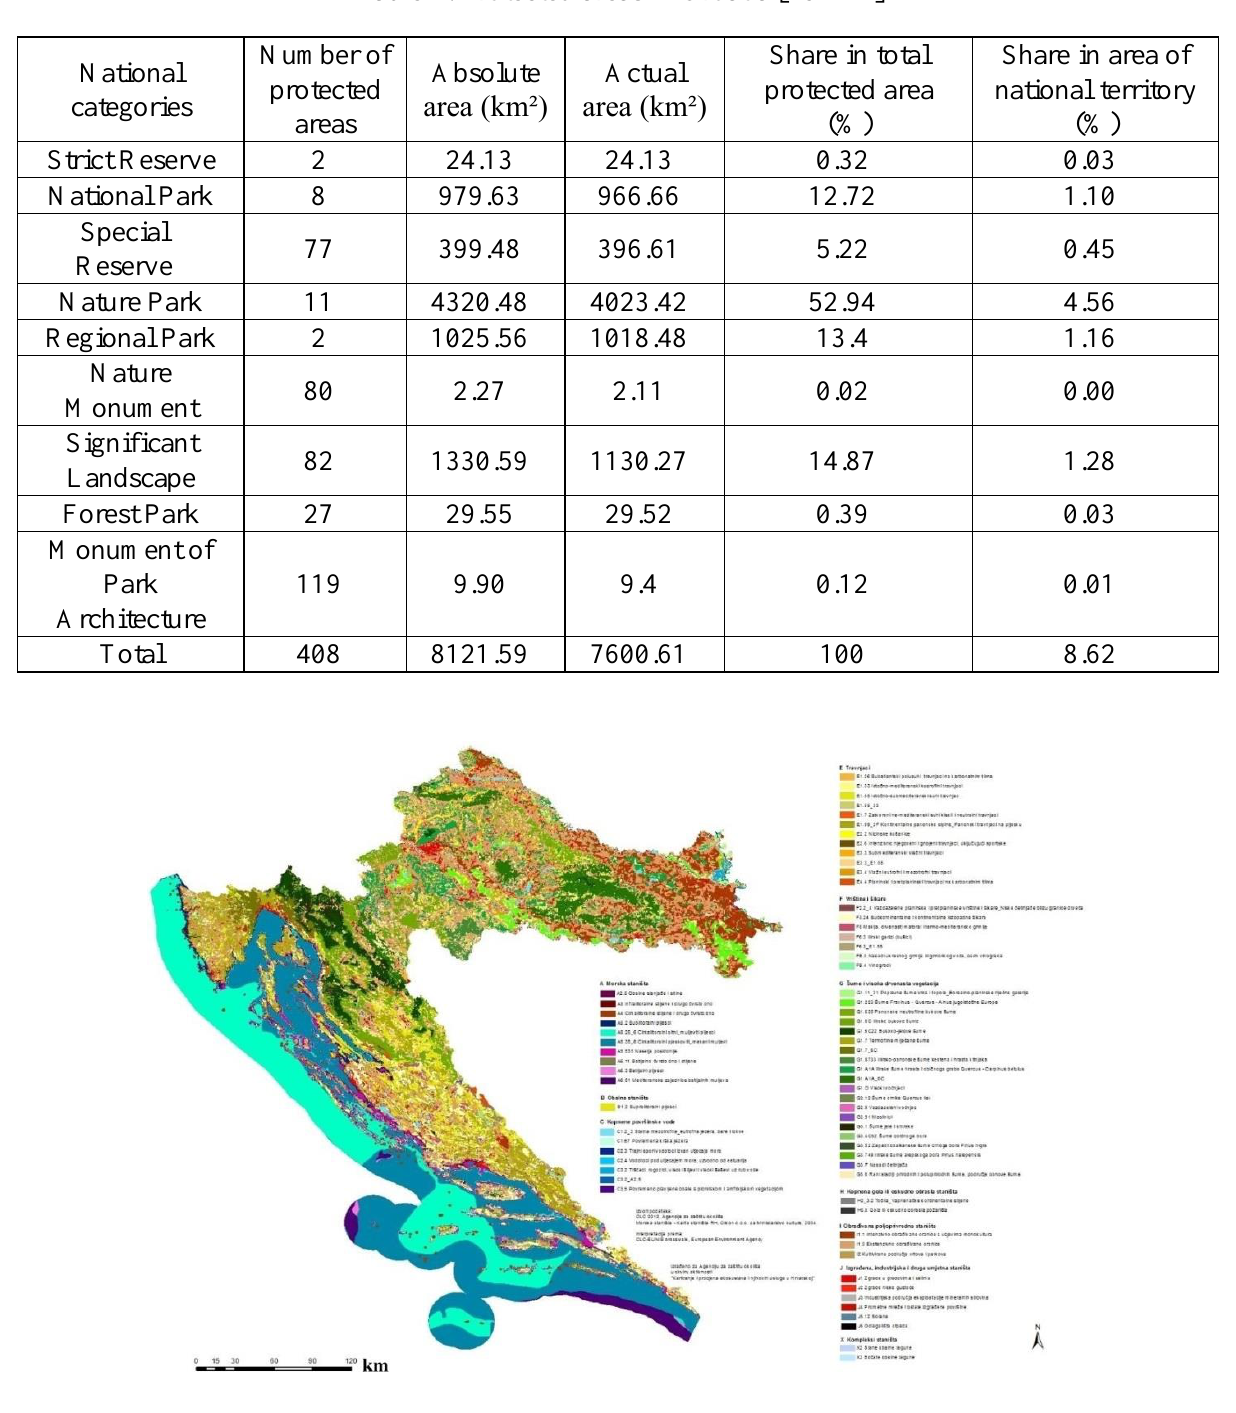
Figure 1. Ecosystems map of Croatia